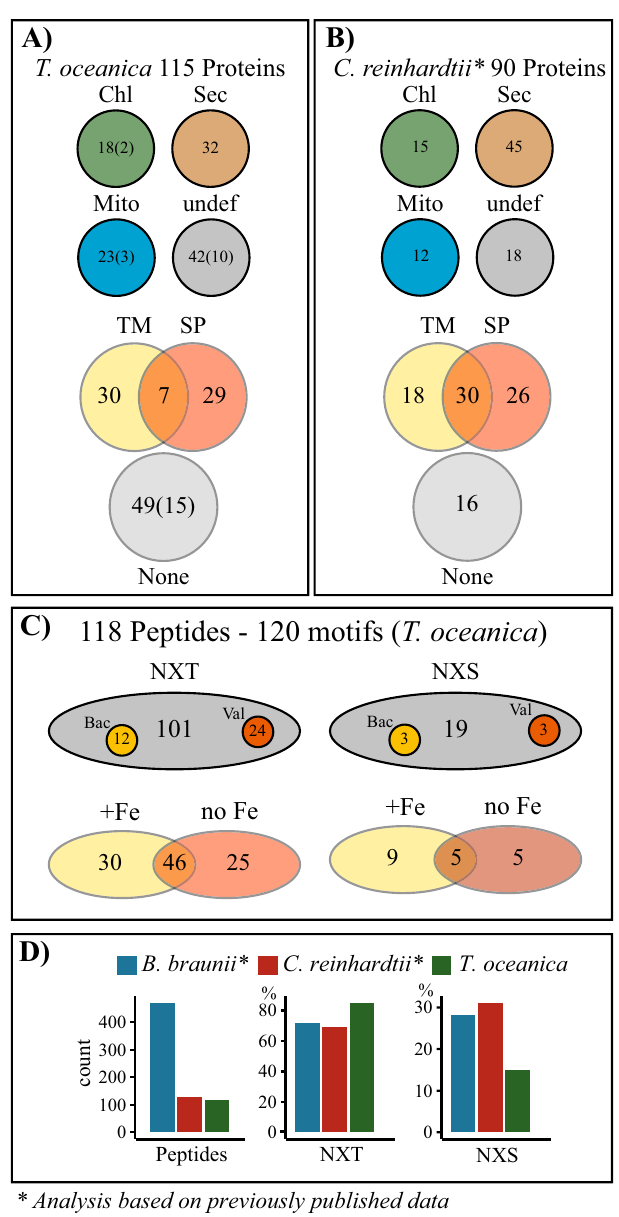
Figure 3. Overview of N-linked glycosylated proteins and peptides. ( A ) Overview of the 115 identified proteins in T. oceanica . The proteins are grouped into their respective predicted cellular localization (chloroplast (Chl); secretory pathway (Sec); mitochondria (Mito); undefined (undef)), predicted with TargetP 1.1 server (Emanuelsson et al. 2005). Furthermore, the proteins are grouped by the presence of transmembrane domains (TM) predicted with TMHMM Server 2.0 62 , and signal peptides (SP) predicted by SignalP 4.0 Server 65 or the absence of transmembrane domains and signal peptides (none). The number of incomplete sequences is shown in brackets. ( B ) Overview of previously published glycosylated proteins identified in C. reinhardtii 15 . We extracted the sequences of 90 previously published proteins from C. reinhardtii 15 that were N-linked glycosylated and performed the same analysis as for T. oceanica . The same servers were used to analyze the subcellular localization. ( C ) The 120 motifs identified in T. oceanica are shown in terms of the motif type (NXT or NXS) with one letter code for the amino acid and x being any amino acid except proline. Small circles within the grey circles show the number of motifs that could be putatively bacterial (orange) or that have a valine (red). The numbers of motifs found in high-iron treatment (yellow), low-iron treatment (brown), or both treatments (overlapping area) are shown. ( D ) Comparison with peptides found in B. braunii 16 and C. reinhardtii 15 . We analyzed the peptides from both studies with respect to the type of motif (NXT; NXS) and compared these findings to our data from T.oceanica . Shown are the total motifs found in each study and the percent of NXT and NXS